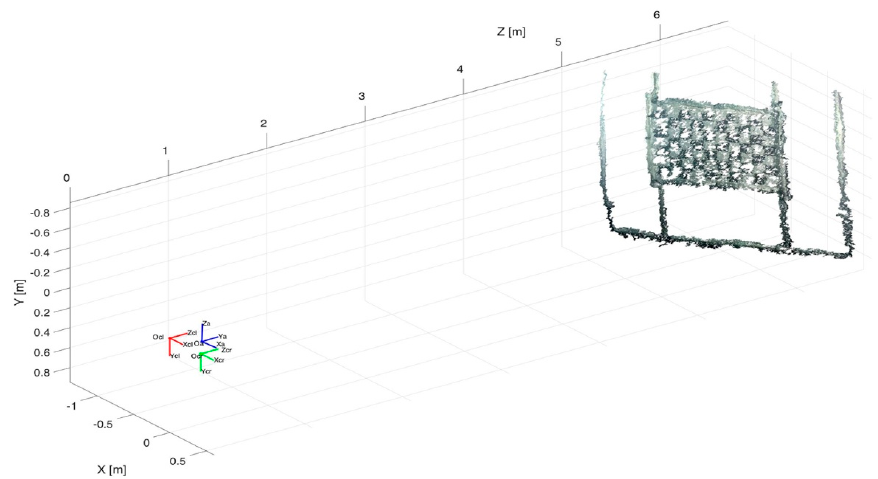
Figure 17. Relative pose of the optical cameras and Echoscope coordinate systems for one pose of the orientation frame.